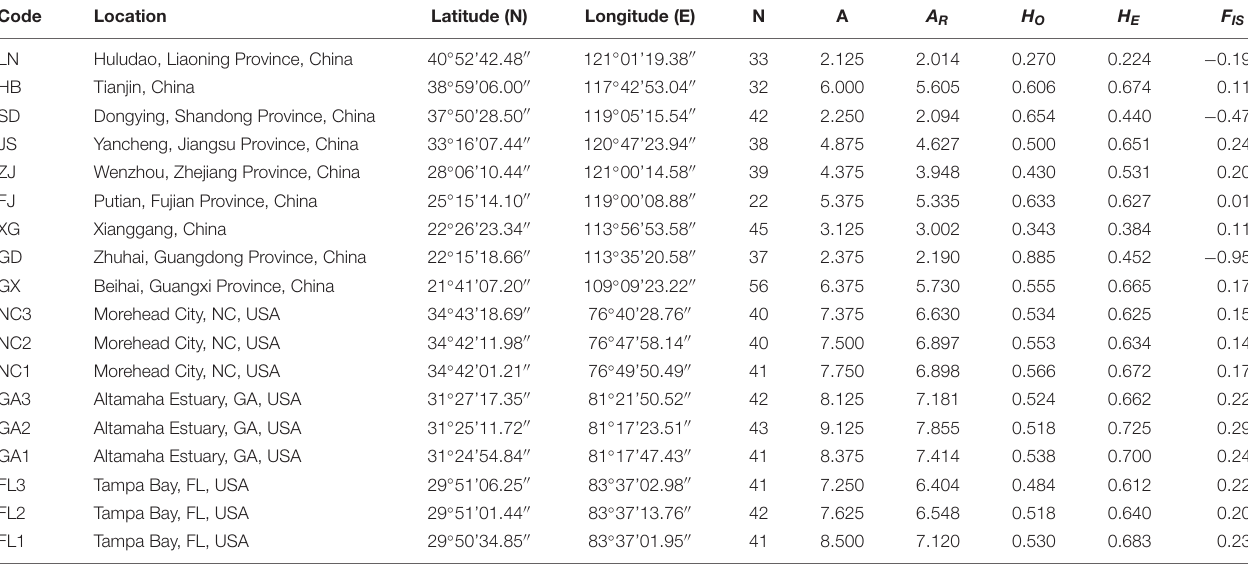
TABLE 2 | Geographic location and population genetic parameters for each site sampled. Code Location Latitude (N) Longitude (E)